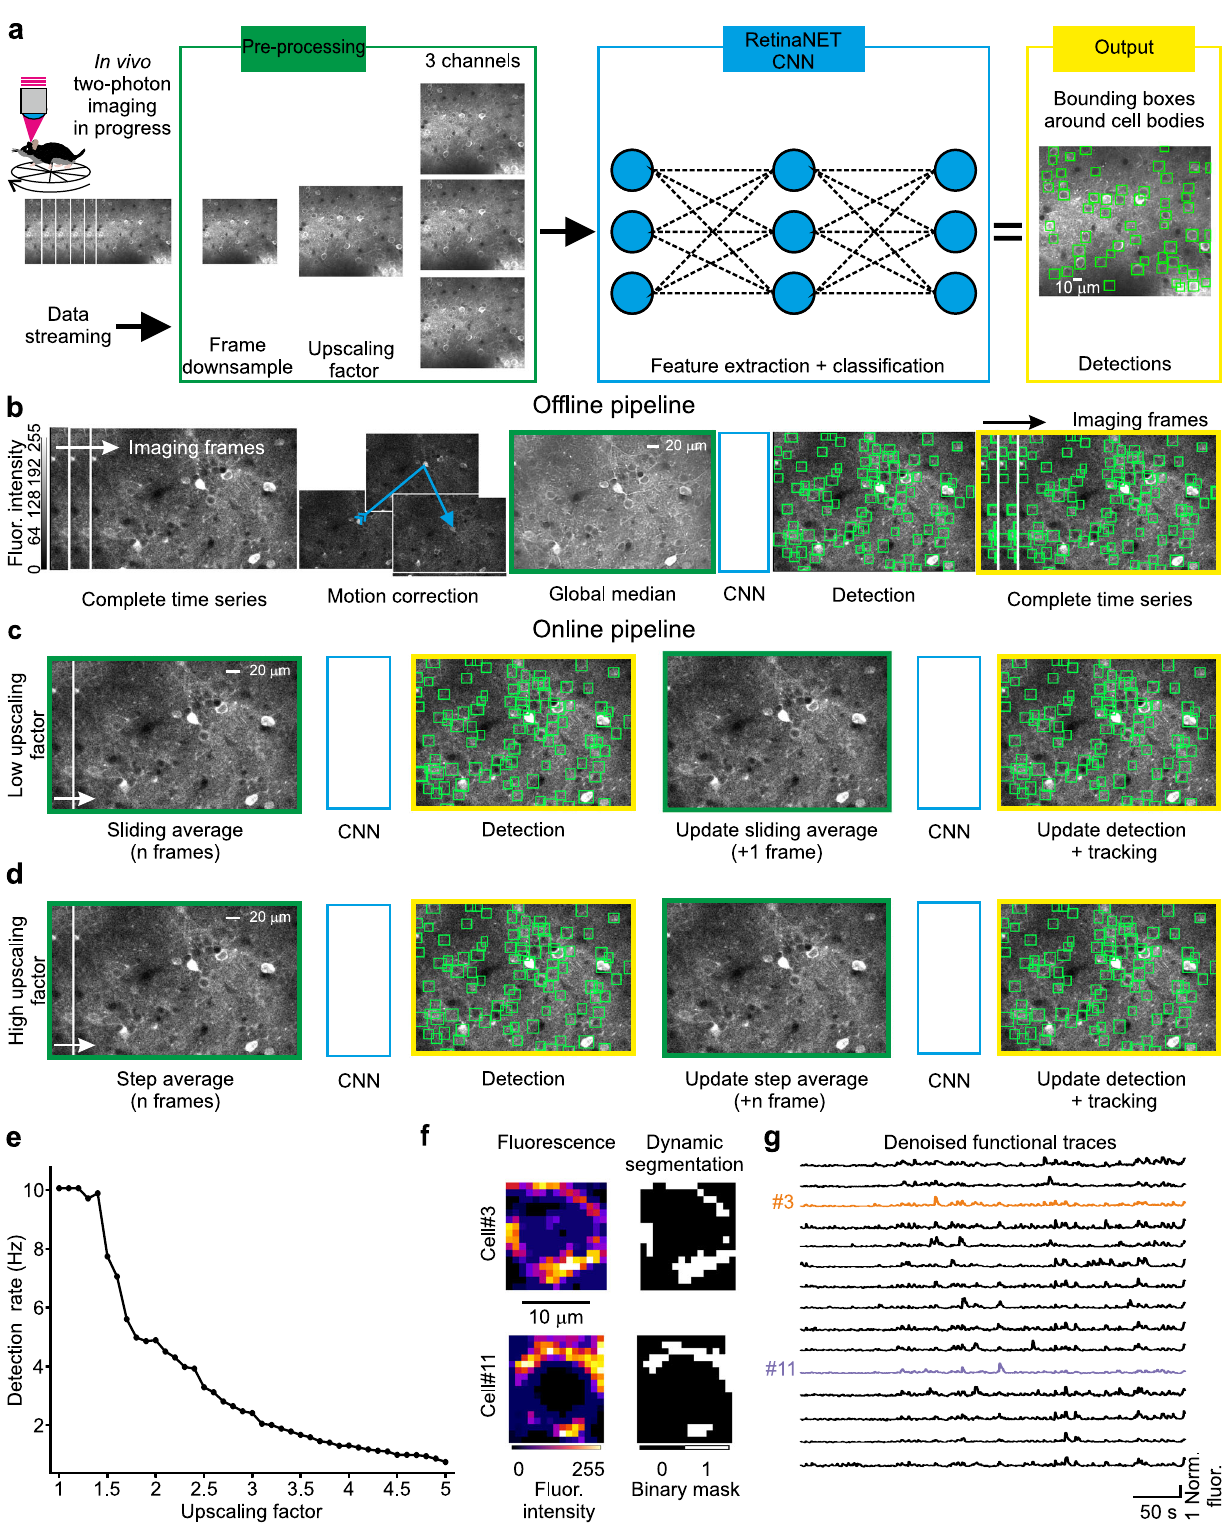
image (detection in Fig. 1b), and bounding boxes were generated for each frame of the t-series (Fig. 1b, yellow highlights). Each bounding box was associated with a score, representing network con fi dence in cell detection. We de fi ned the intersection over union (IoU) for two identi fi ed bounding boxes as the proportion of the overlapping area between two boxes out of the sum of the areas of the two boxes. Bounding boxes with intersection over